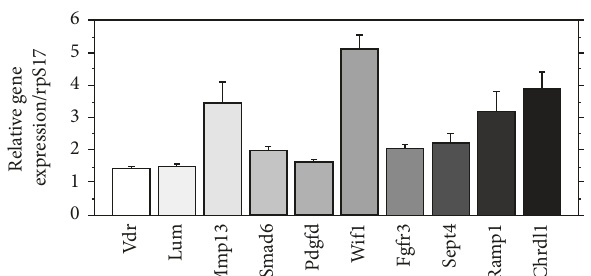
Figure 1: RT-PCR for 10 genes in relation to cell proliferation and differentiation. Each bar indicates the SD of triplicate